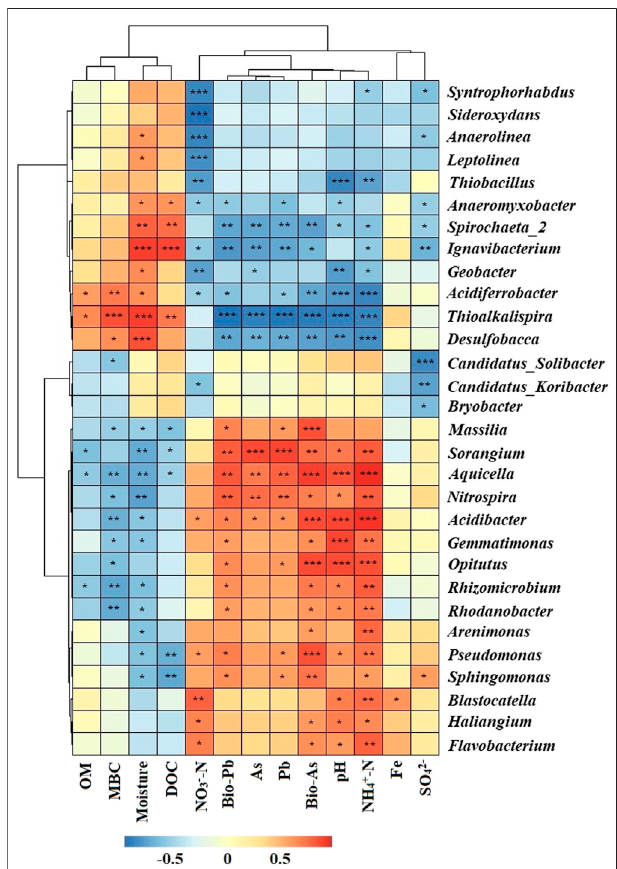
FIGURE 5 | Heatmap of Spearman ’ s rank correlations coef fi cients between geochemical parameters and the relative abundance of top 35 bacterial genera. The corresponding value of heatmap is Spearman correlation coef fi cient where “ r ” value is between − 1 and 1, r < 0 is negative correlation, r > 0 is positive correlation. The asterisk indicates signi fi cant differences. * p < 0.05, ** p < 0.01, *** p < 0.001. Abbreviations: As, Pb, Fe (total As, Pb, Fe in soil); Bio-As, Pb (bioavailability As, Pb); MBC (microbial biomass carbon); OM (organic matter); DOC (dissolved organic